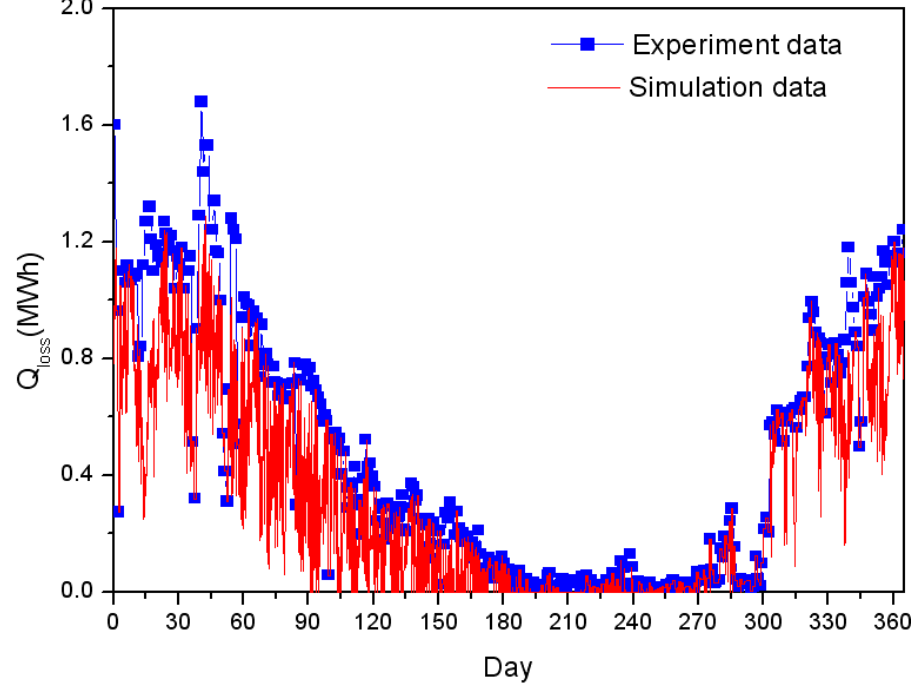
Figure 18. Comparison of heat loss for a year for original and optimal heat supply